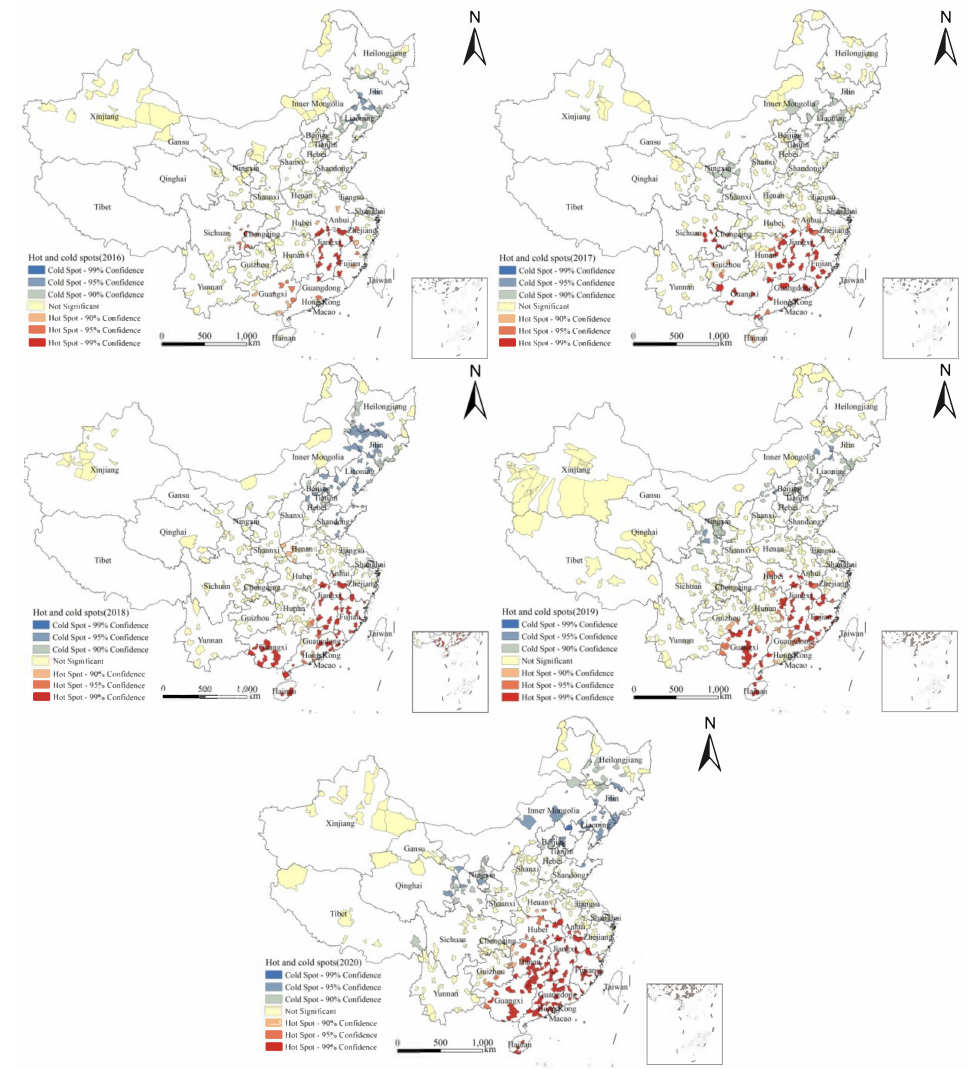
Figure 4. The county-level results of Getis-Ord Gi * from 2016 to